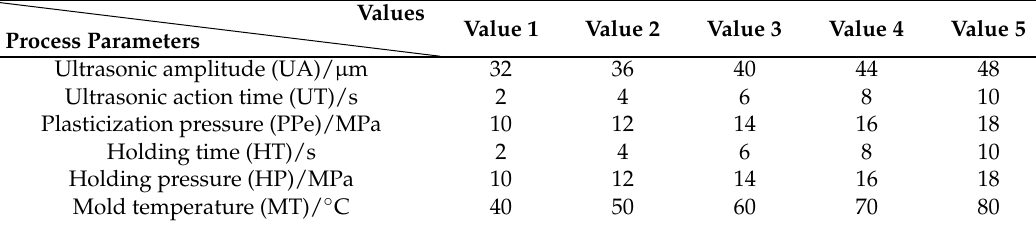
Table 2. Investigated process parameters and their